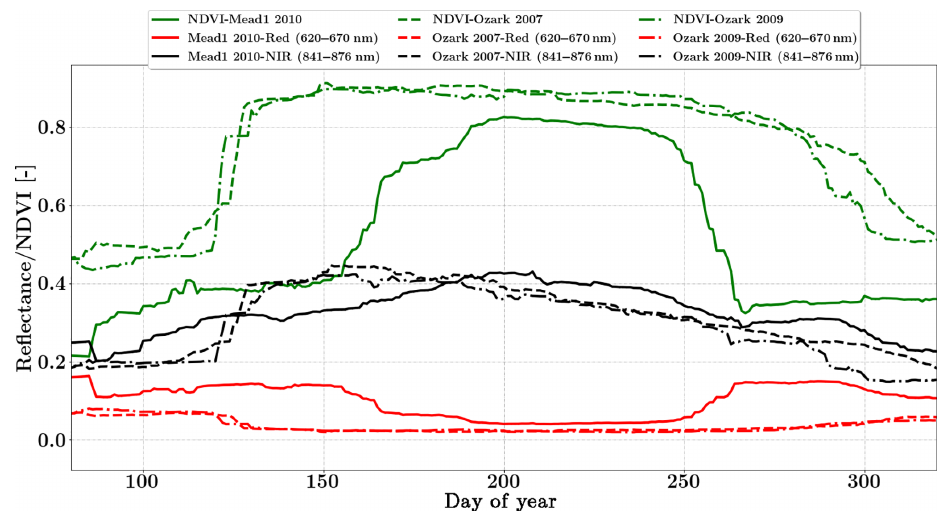
Figure 5. Figure showing the seasonal variability of red, NIR MODIS nadir reflectance and NDVI for the Nebraska Mead-1 and Missouri Ozark Site. This dataset is used in SCOPE model inversions in conjunction with fluxes of carbon and water for retrieval of ecosystem